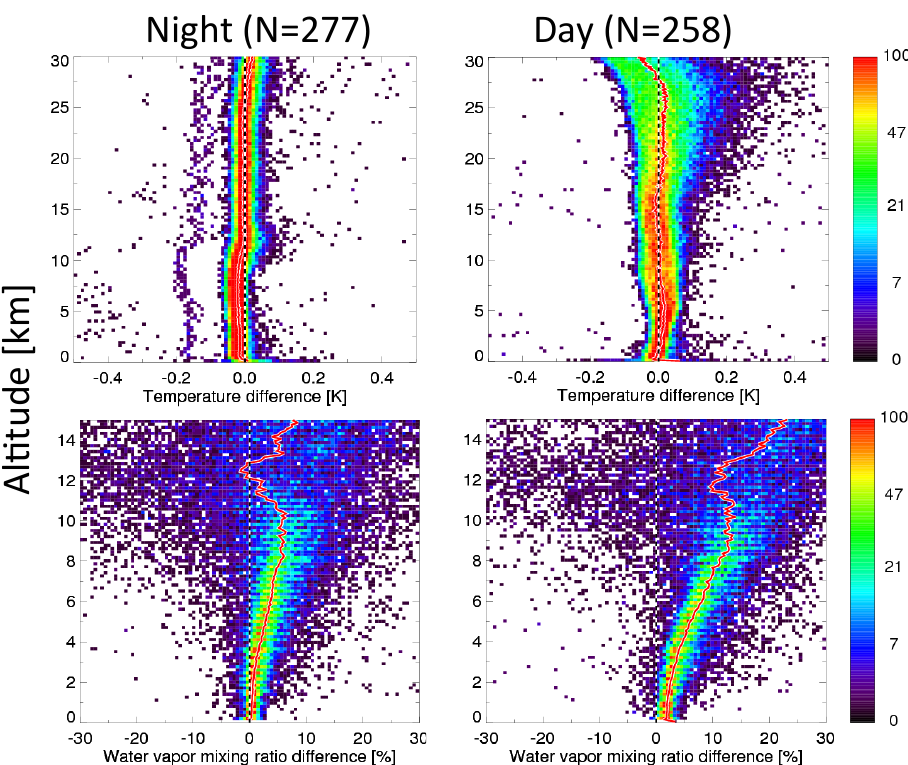
Figure 17. Comparison of GRUAN data processing (GDP) and Vaisala (FLEDT) for RS92 radiosoundings performed in Lindenberg in 2012. The graphs show scatter density plots of 100% × ( GDP − FLEDT )/ GDP for temperature (top row) and humidity (bottom row). Data were taken from radiosoundings performed at local midnight (00:00UTC, left column, N = 277) and local noon (12:00UTC, right column, N = 258). The GRUAN and Vaisala profile data are gridded in 100m wide altitude bins prior to comparison. The logarithmic colour scale represents the number of data points in each bin, and the solid red line represents the average. Bins containing fewer than five data points are excluded from the plot. The tropopause (not indicated) usually resides below 12km.